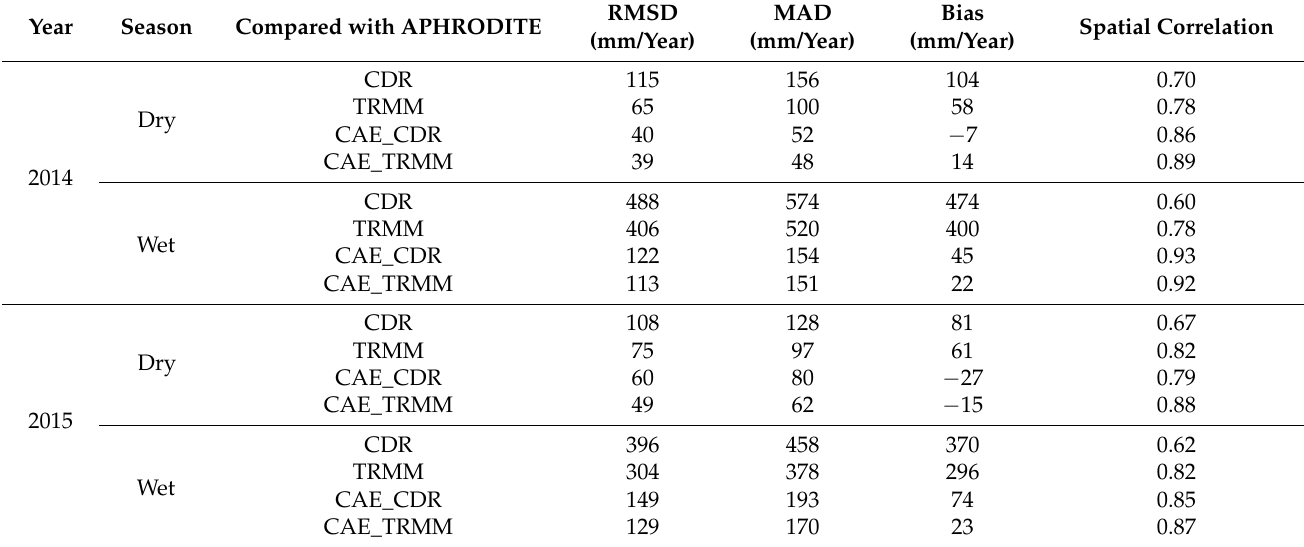
Table 4. Quantitative assessment of seasonal precipitation spatial correlation of